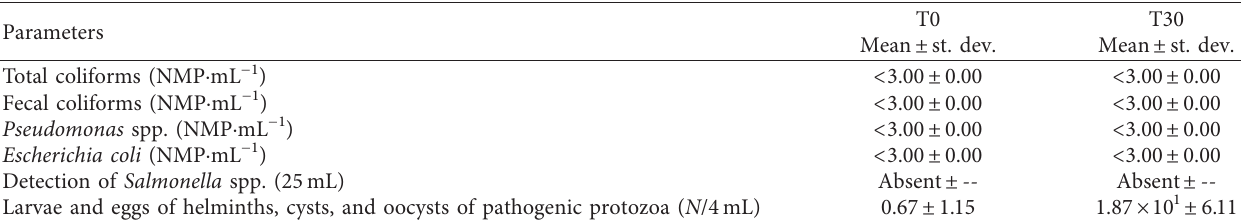
T0 T30 Mean ± st. dev. Mean ± st.